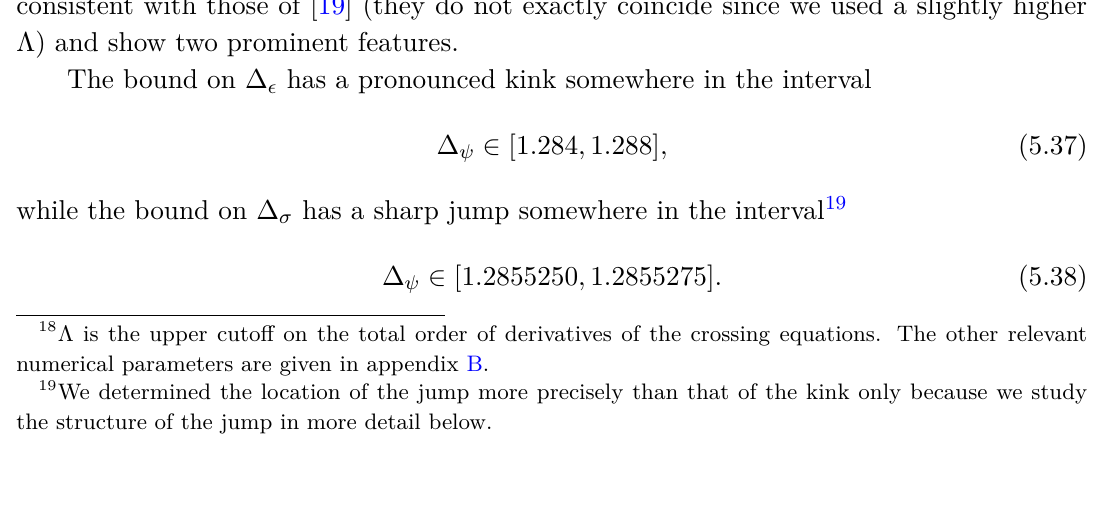
in the parity-odd scalar sector. Both plots were computed at Λ = 27. σ